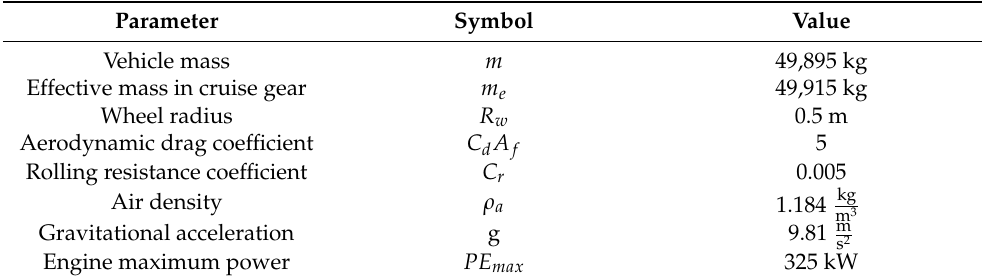
Table 2. Vehicle parameters.